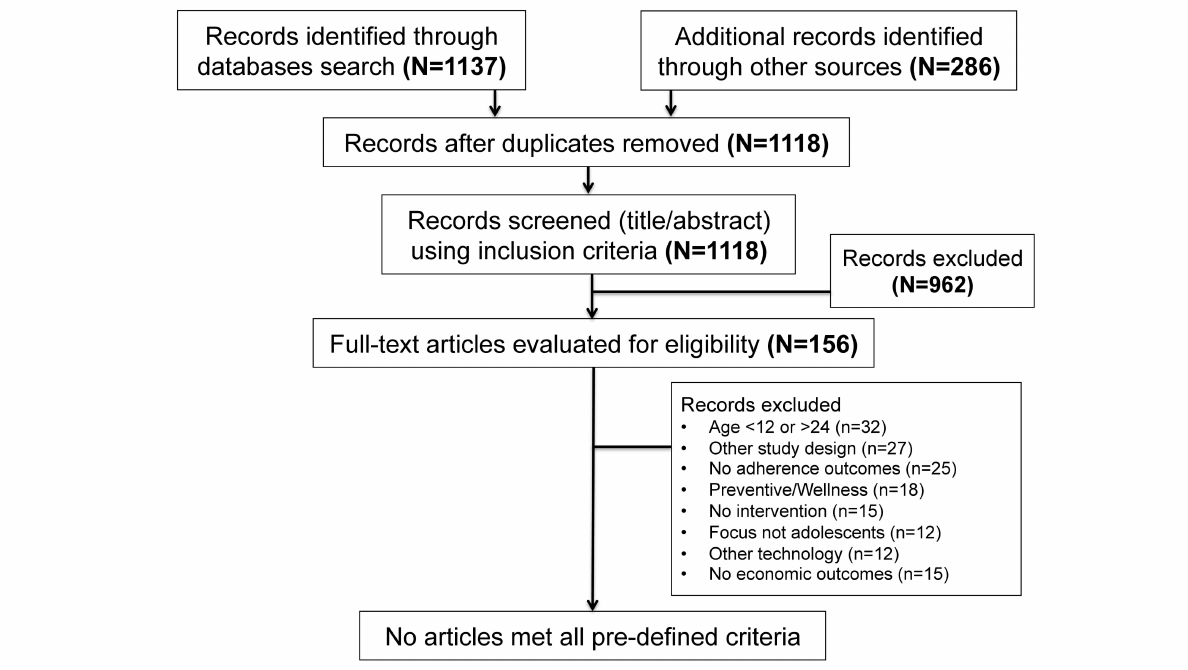
Figure 1. Flow of studies through the review according to the Preferred Reporting Items for Systematic Reviews and Meta-Analyses (PRISMA)